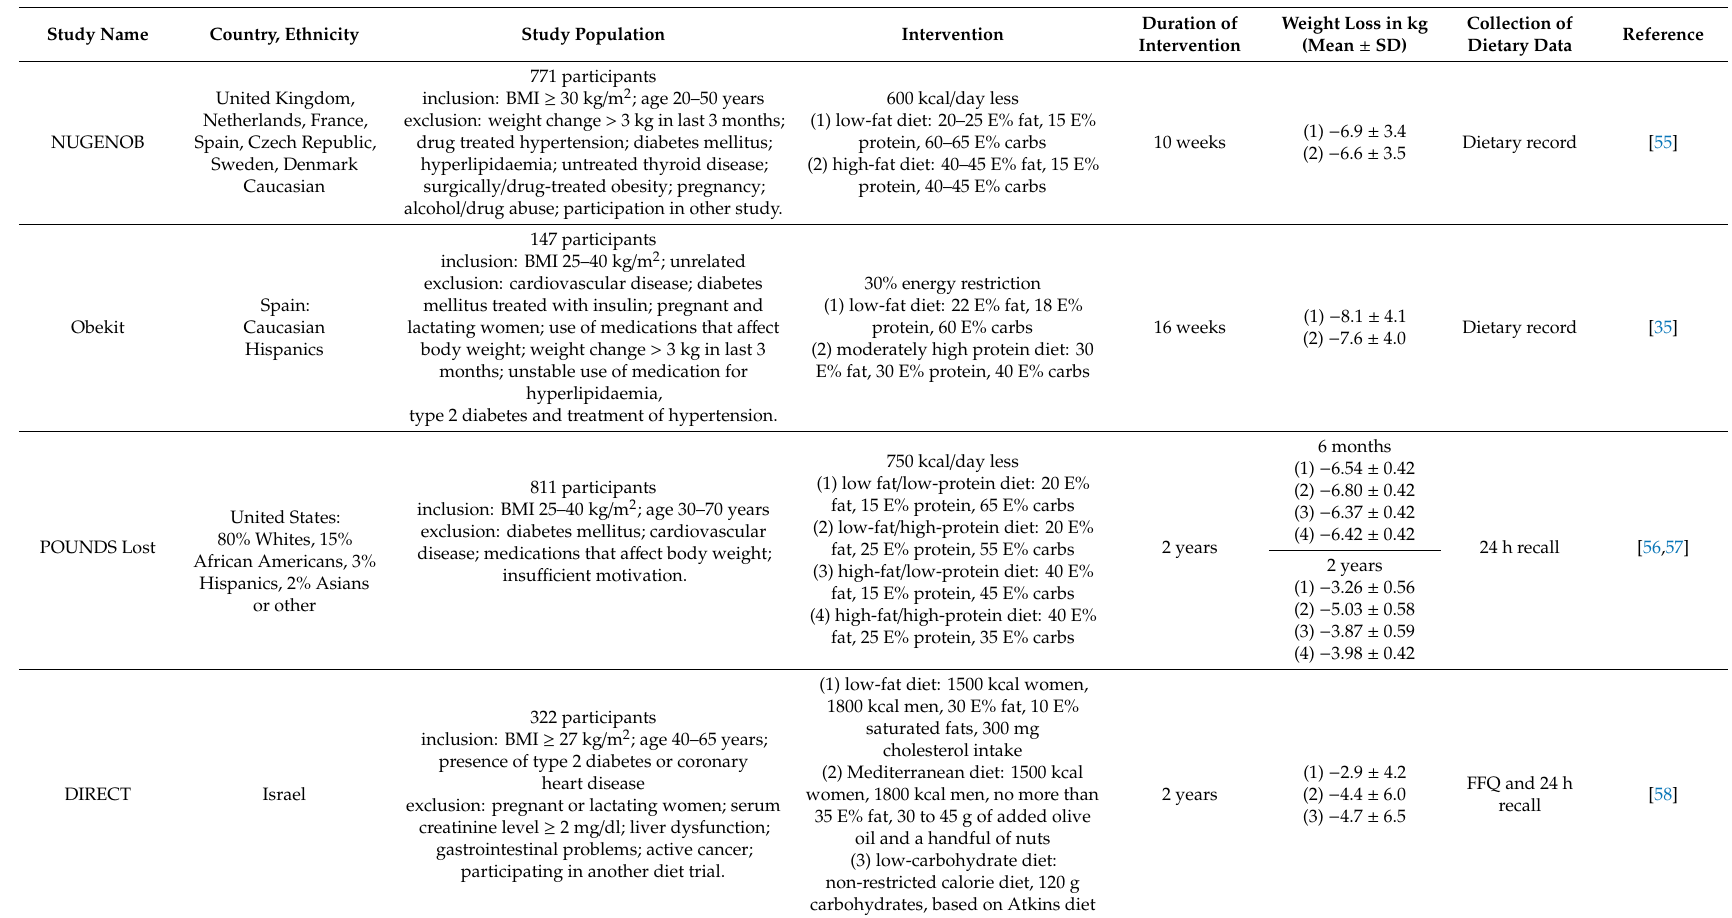
Table 1. Description of the